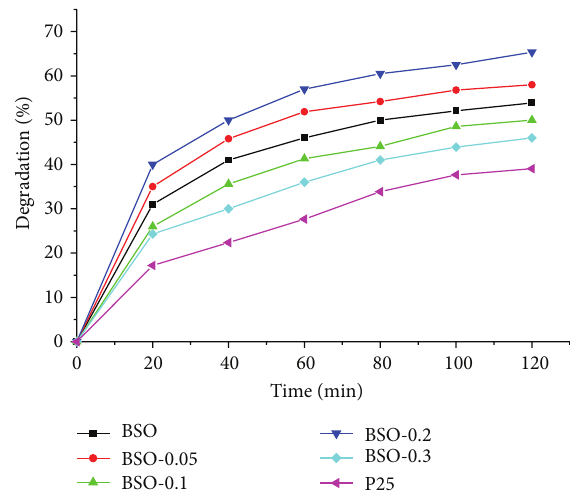
Figure 5: Photocatalytic performance of Fe 3 O 4 @SiO 2 /Bi 2 SiO 5 composites and P25.